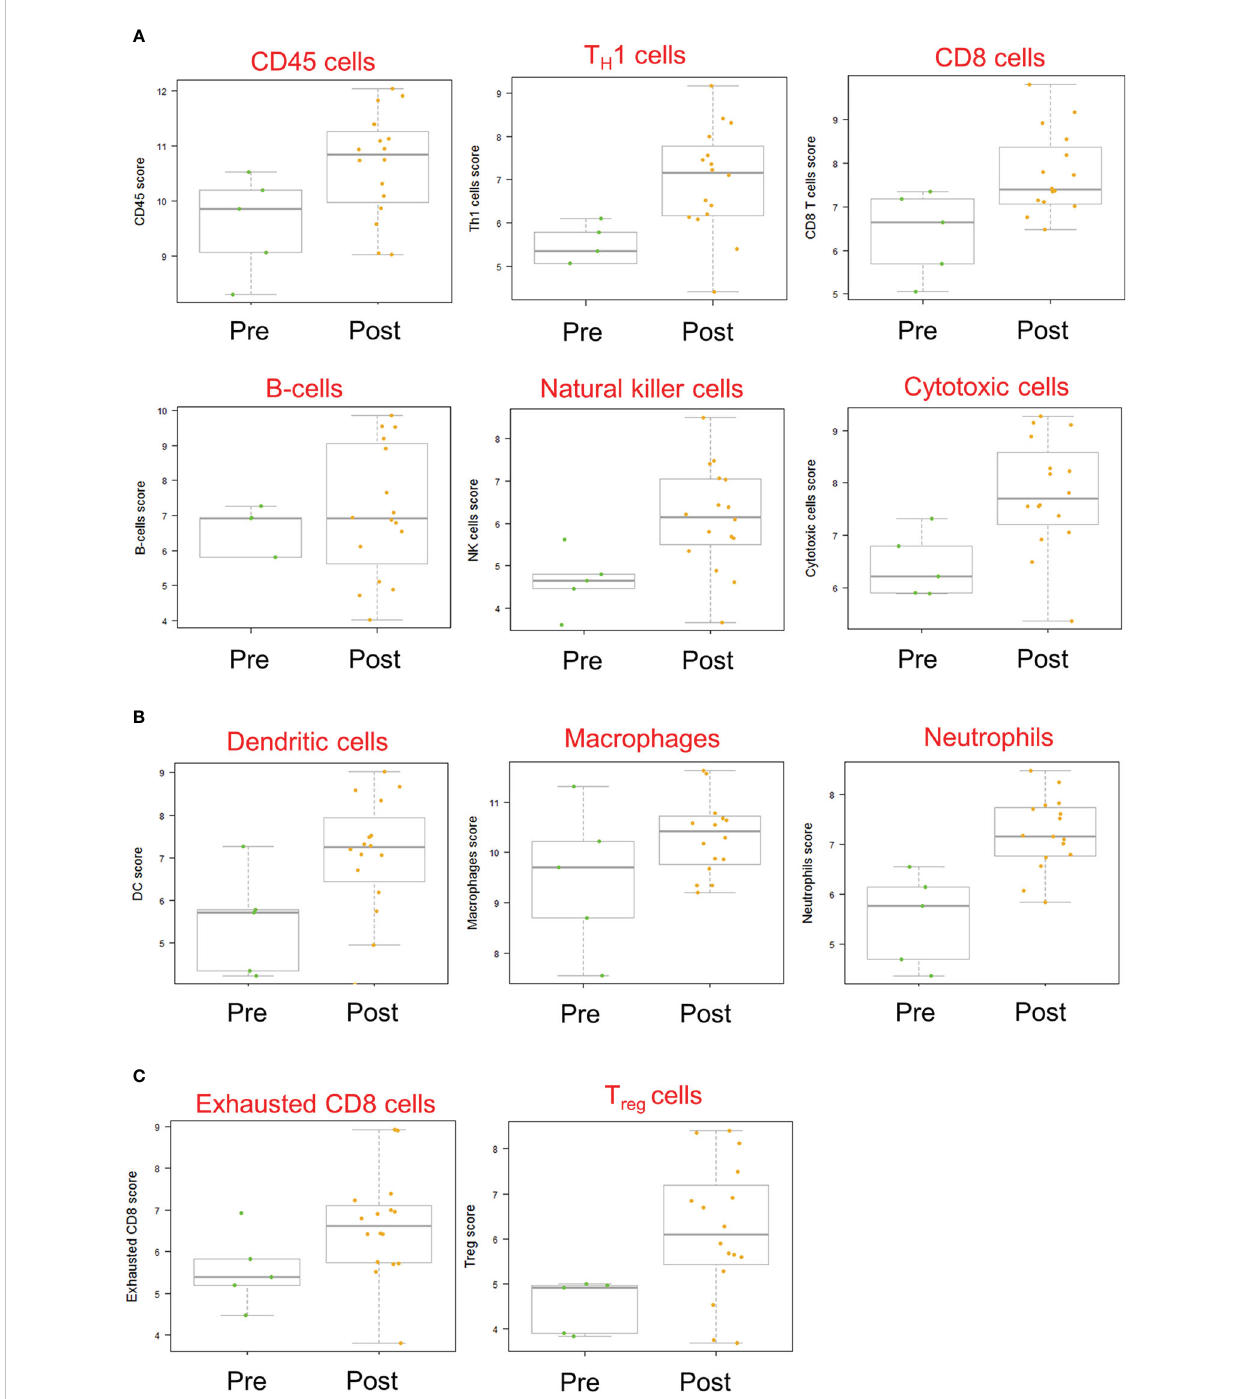
FIGURE 6 Immune cell scores based on mRNA transcript abundance before and after Olvi-vec therapy. (A – C) Total RNA was isolated from MPM tumor sections before and after Olvi-vec therapy. The number of mRNA transcripts speci fi c to (A) lymphoid, (B) myeloid, and (C) exhausted and regulatory cell types were quanti fi ed. A score increase of one indicates a two-fold increase in cell population abundance in a sample. Bars indicate mean, interquartile range, and